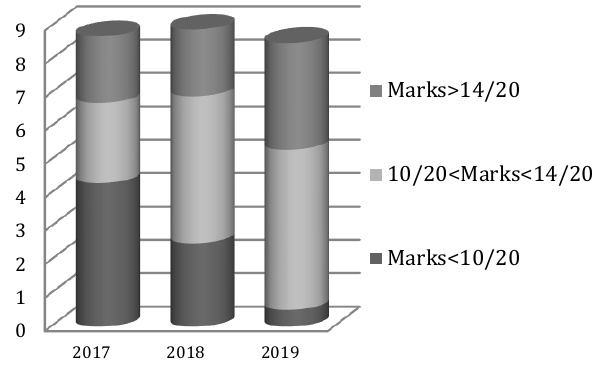
Fig. 6. Students Marks variations from 2017 to